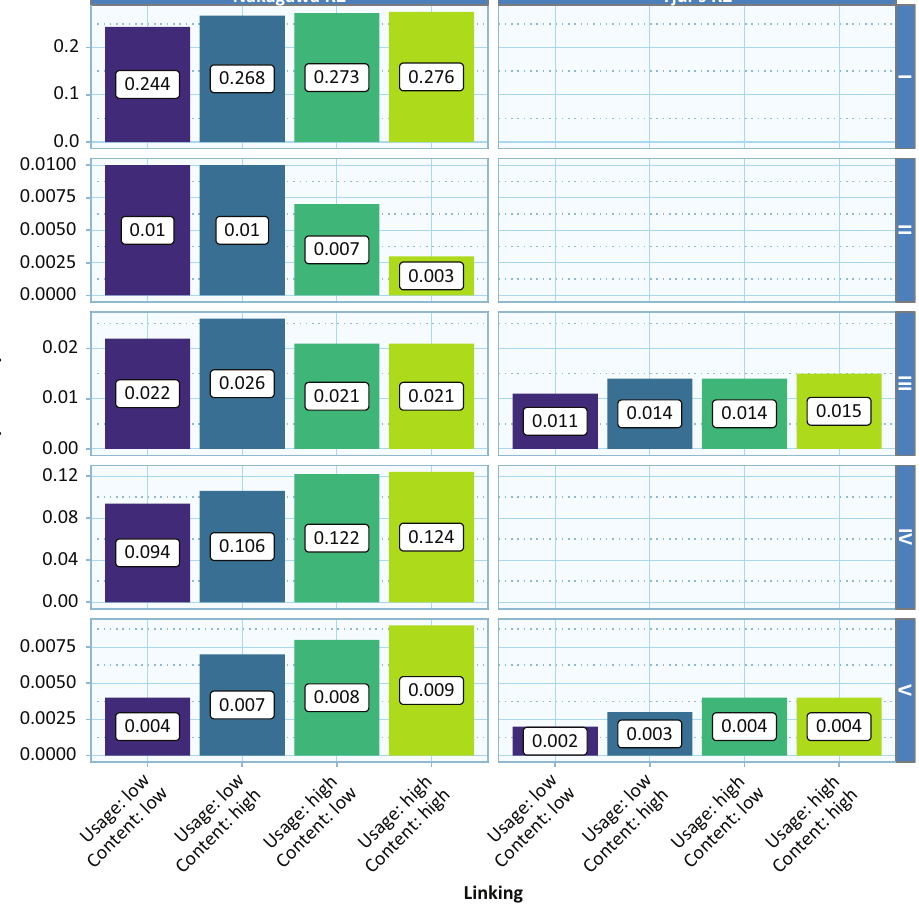
Figure 4. Change in explanatory power when adding media salience to explain issue salience.